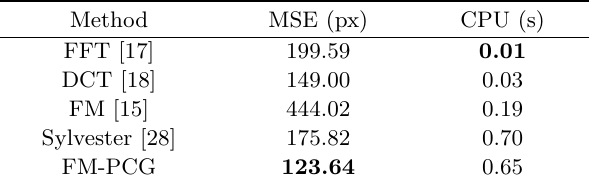
Table 13 Results on the “Lena” dataset for the non-rectangular domain in Fig. 12(a) Method